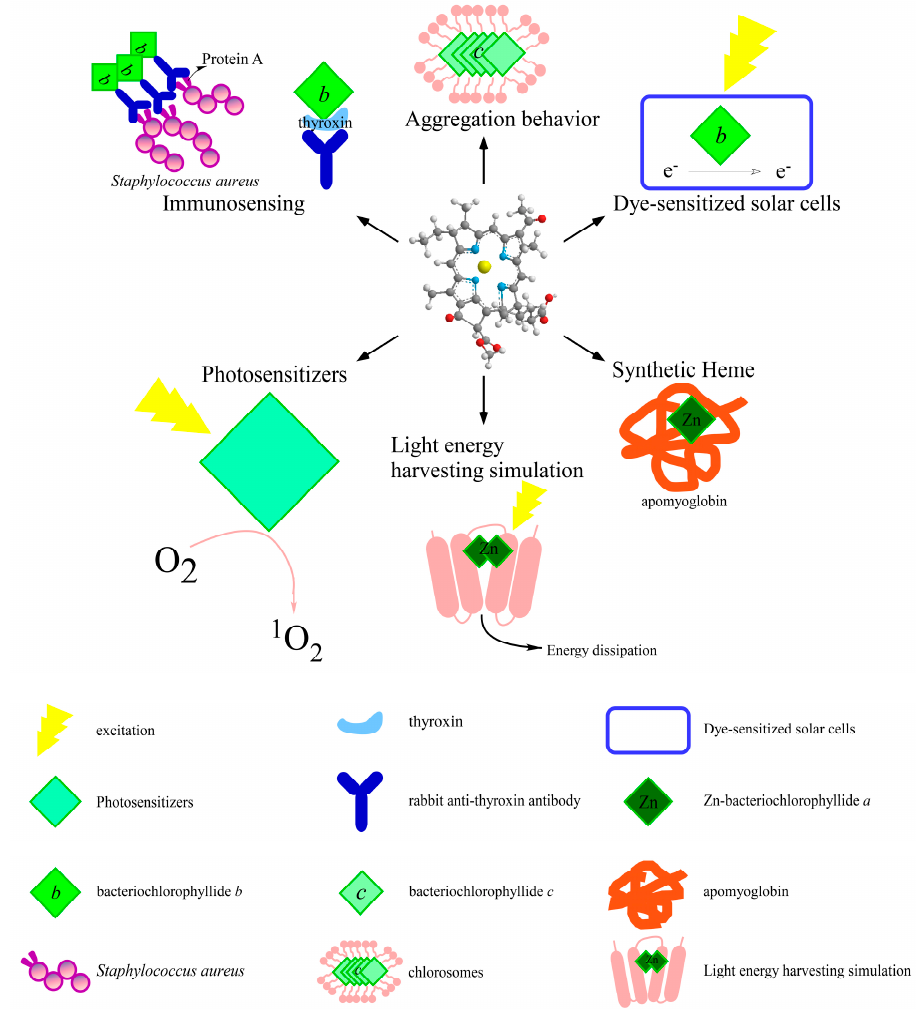
Figure 4. Some applications of bacteriochlorophyllides derivatives.